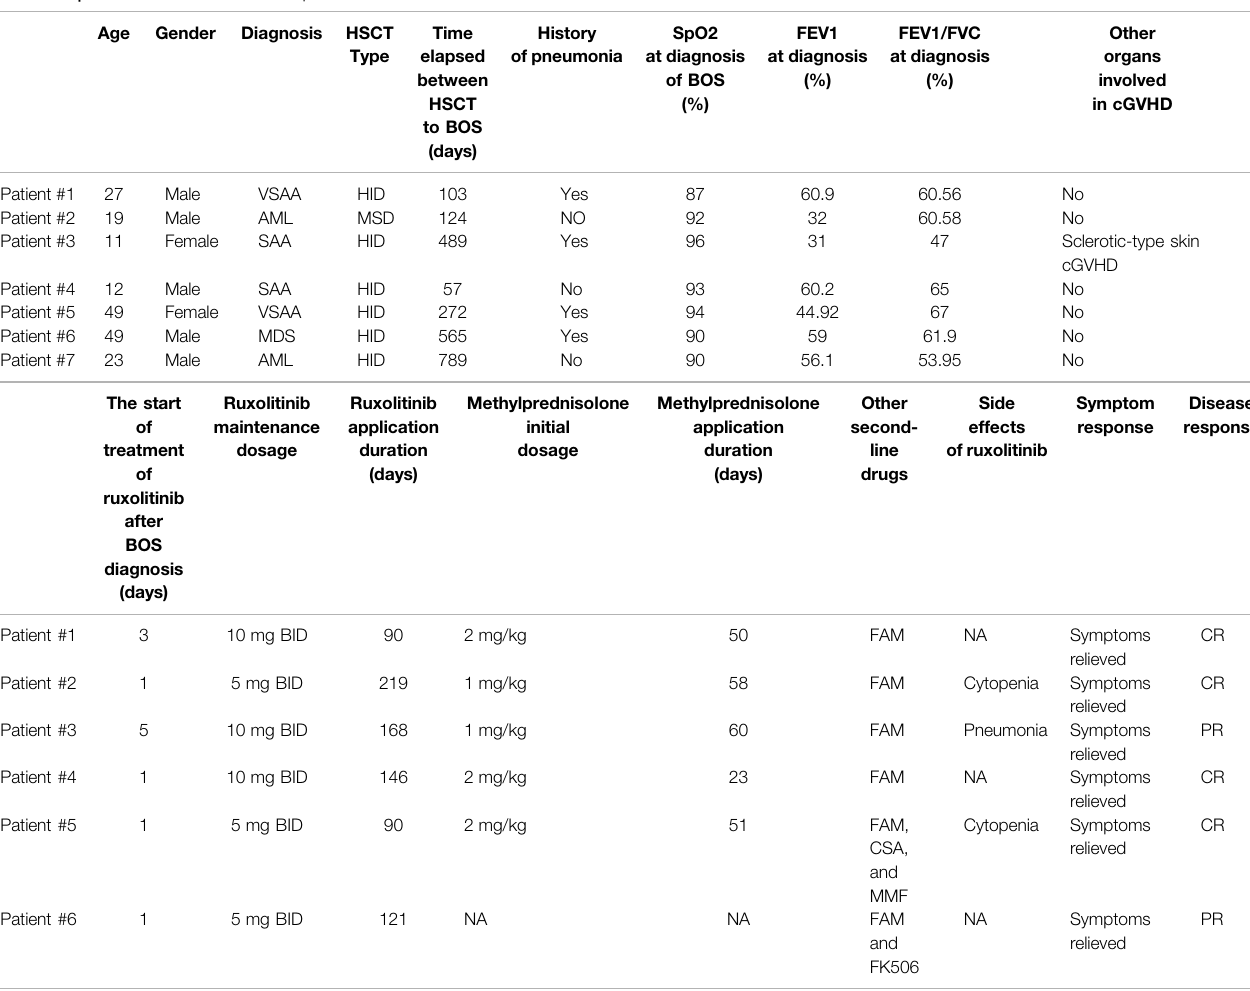
TABLE 1 | Characteristics of seven BO patients.